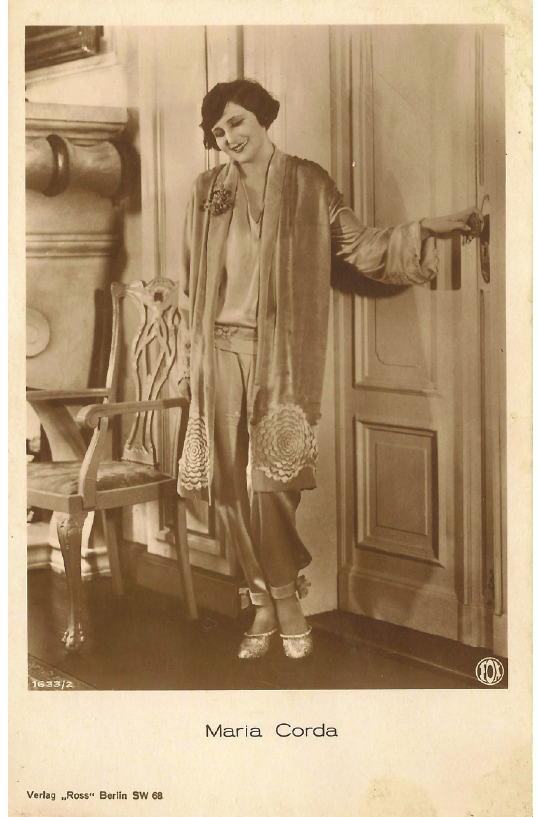
Figure 12. The photograph was taken on the film set and shows Maria Corda as Elyana at a point when she has just realized how much Paul enjoys playing with the neighbours’ children. Note her fantastic outfit.